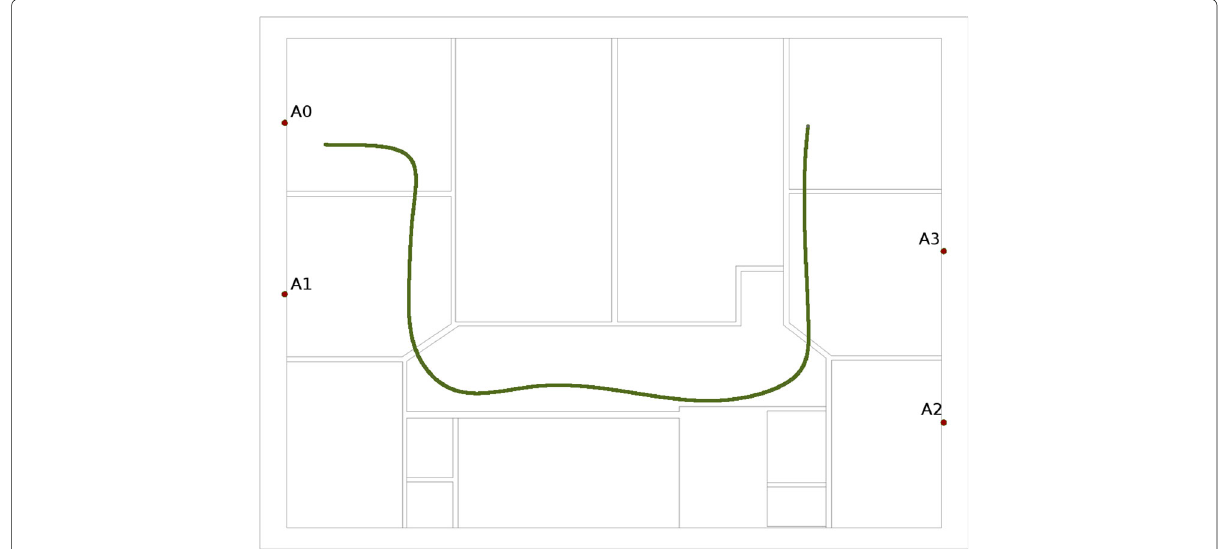
Fig. 2 Ground plan of a reference 15.38 m × 11.5 m office environment with 21.73 m walking path used in simulations and